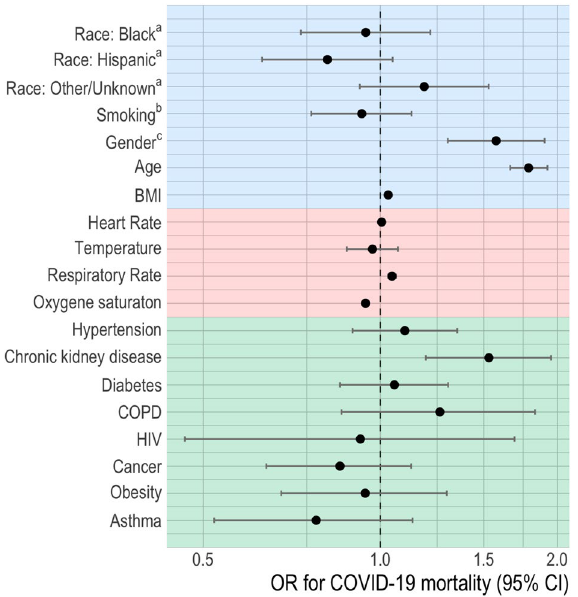
Figure 1. Associations (odds ratio and 95% intervals) of demographics, clinical factors, and comorbidities and COVID-19 mortality. OR odds ratio, BMI body mass index, COPD chronic obstructive pulmonary disease, HIV human immunodeficiency virus. Clinical factors were assessed at triage. a In reference to White. b Ever smoked in reference to never smoked. c Males in reference to females. Factors are color coded to indicate the group of characteristics (Blue = Demographics, Red = clinical factors, Green = comorbidities).